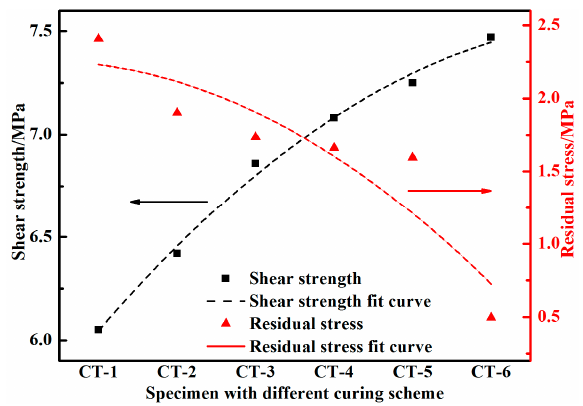
Figure 11. The residual stress effect of the SLJ on the shear strength.